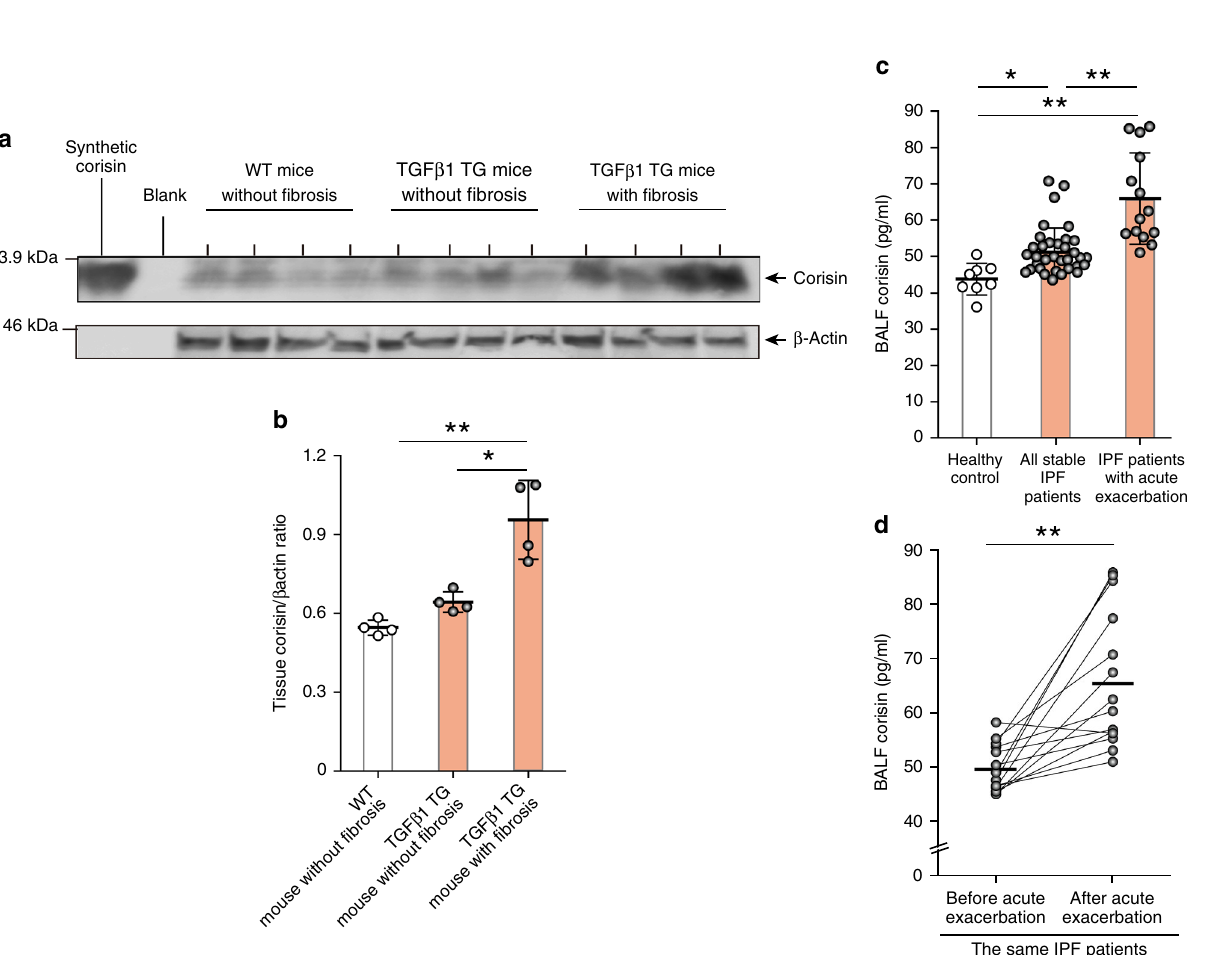
Fig. 8 Signi fi cant increase in corisin level in TGF β 1 TG mice with lung fi brosis and in patients with idiopathic pulmonary fi brosis. a , b Western blotting of corisin in lung tissue from wild-type and transforming growth factor (TGF) β 1 transgenic (TG) mice performed as described under methods and the ratio of corisin to β -actin. Quanti fi cation was performed using ImageJ, a public domain image processing program. Each mouse group with n = 4. Bars indicate the means± S.D. Statistical analysis by ANOVA with Tukey ’ s test. * p < 0.01, ** p < 0.001. c Corisin was measured using a competitive enzyme immune assay as described under methods. Healthy controls, n = 8; all stable idiopathic pulmonary fi brosis (IPF) patients, n = 34; IPF patients with acute exacerbation, n = 14. Bars indicate the means ± S.D. Statistical analysis by ANOVA with Newman-Keuls test. * p < 0.05, ** p < 0.001. d Analysis of bronchoalveolar lavage fl uid levels of corisin in the same IPF patients before and after acute exacerbation, n = 14. Bars indicate the means. Statistical analysis by two-tailed Mann – Whitney U Test. ** p < 0.001. The source data underlying a – d are provided in the Source Data fi